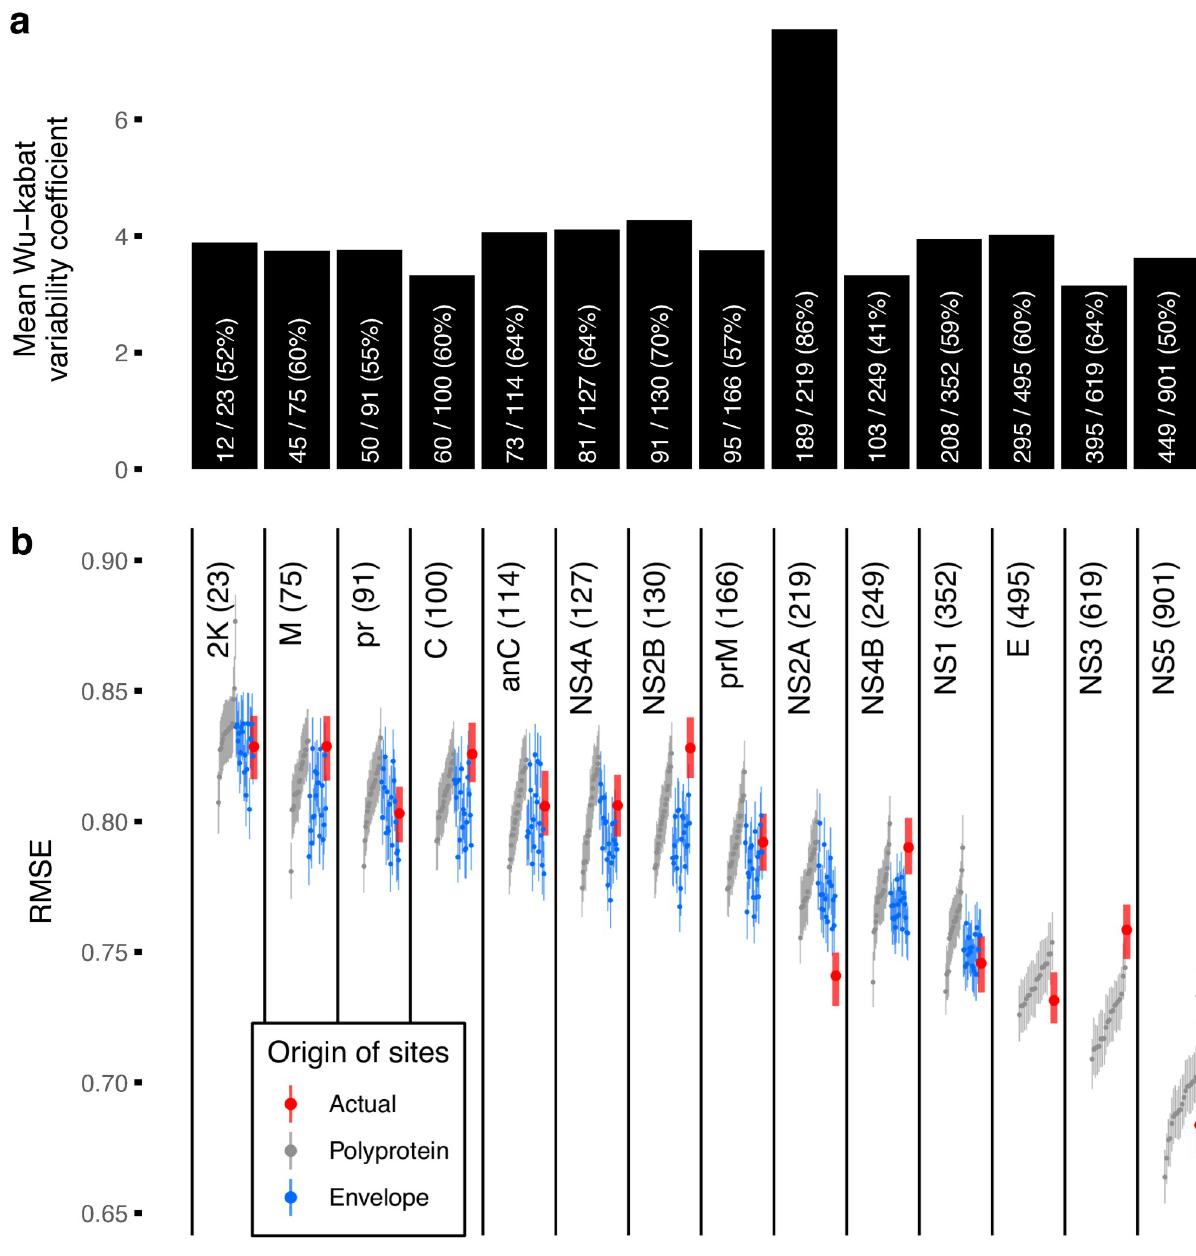
Fig 4. Antigenic signal in each DENV protein. a) Average within site variability in DENV proteins observed in the dataset. Bars were annotated with number of variable sites, total number of sites, and percentage of sites variable. b) Prediction performance of each DENV protein as observed (red) contrasted against expectations derived from random subsample of sites from any DENV protein of the same length (gray) and random down samples of sites from the envelope protein (E, blue). Points and lines are median and 95% interquartile range (IQR) of the root mean squared error (RMSE) evaluated under 100-fold Monte Carlo cross-validation. Length of the proteins are shown in parentheses. Only nonstructural protein 2A (NS2A) appeared to have better predictive performance than the expectations.